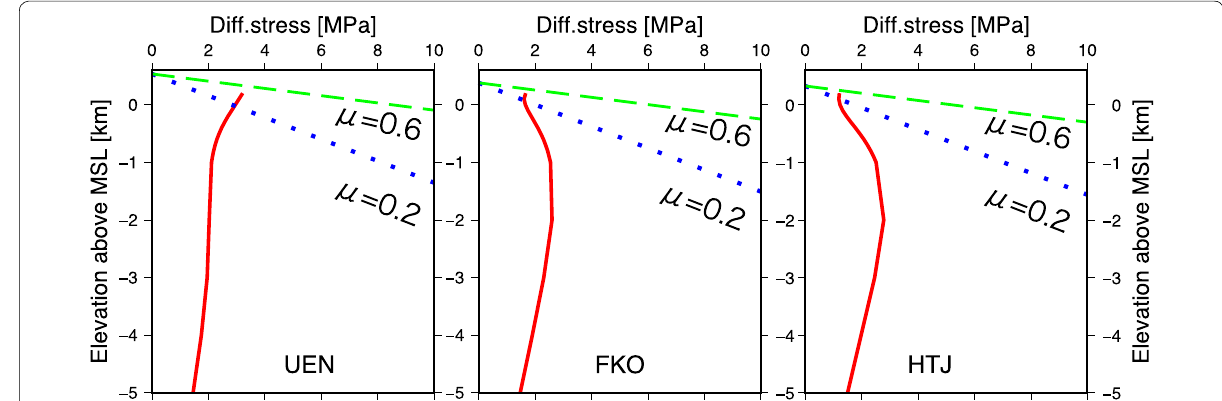
Fig. 3 Depth distribution of the calculated topographical differential stress and fault intensity. The red lines indicate depth distribution of the differential stress. The blue dotted and green dashed lines denote fault strength ( = µρ gz ) with a friction coefficient μ